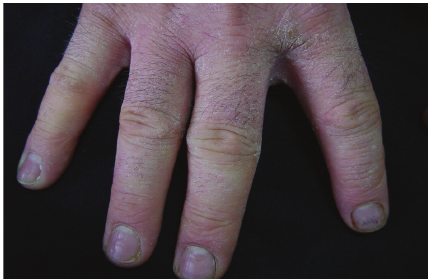
Figure 1: Hand eczema (Case 1).